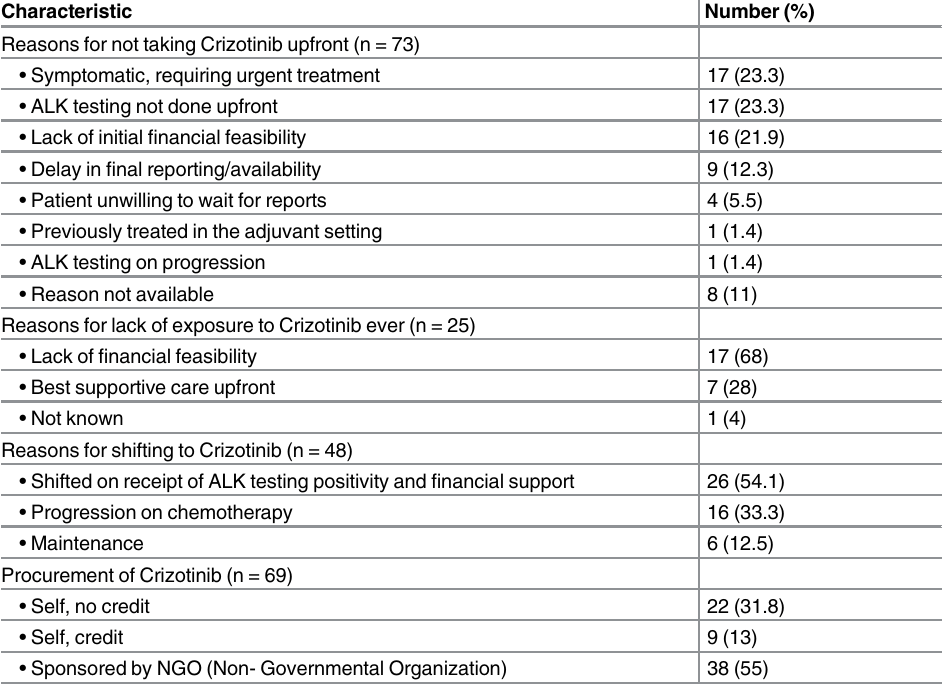
Table 2. Logistic considerations associated with exposure to